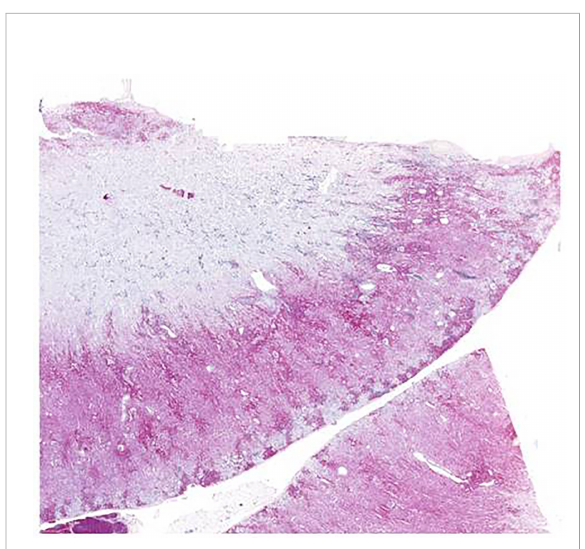
FIGURE 4 Renal biopsy from case 2 with myeloperoxidase staining showing in fi ltration of myeloid precursors; scale bar, 2,000